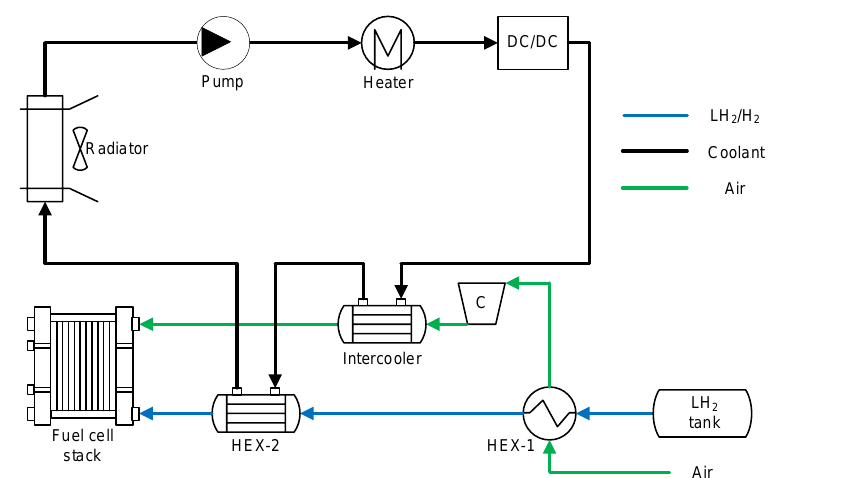
Figure 2. Equipment of original LH 2 system.